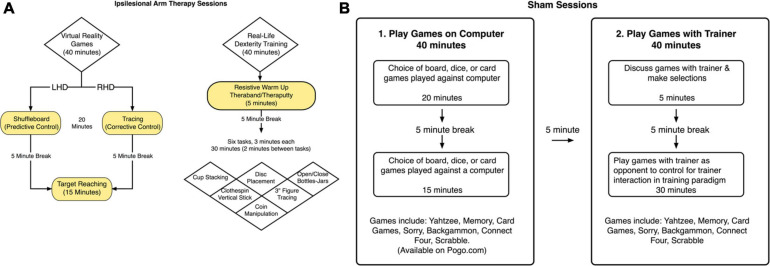
(A) Ipsilesional arm training paradigm. A schematized representation of the components included in the ipsilesional training program. (B) Sham condition. The sham condition was considered to be an attention-control condition. Sham sessions included the same frequency of lab visits and study personnel interaction, but did not include any activities that would be considered motor therapy directed toward the upper extremities.